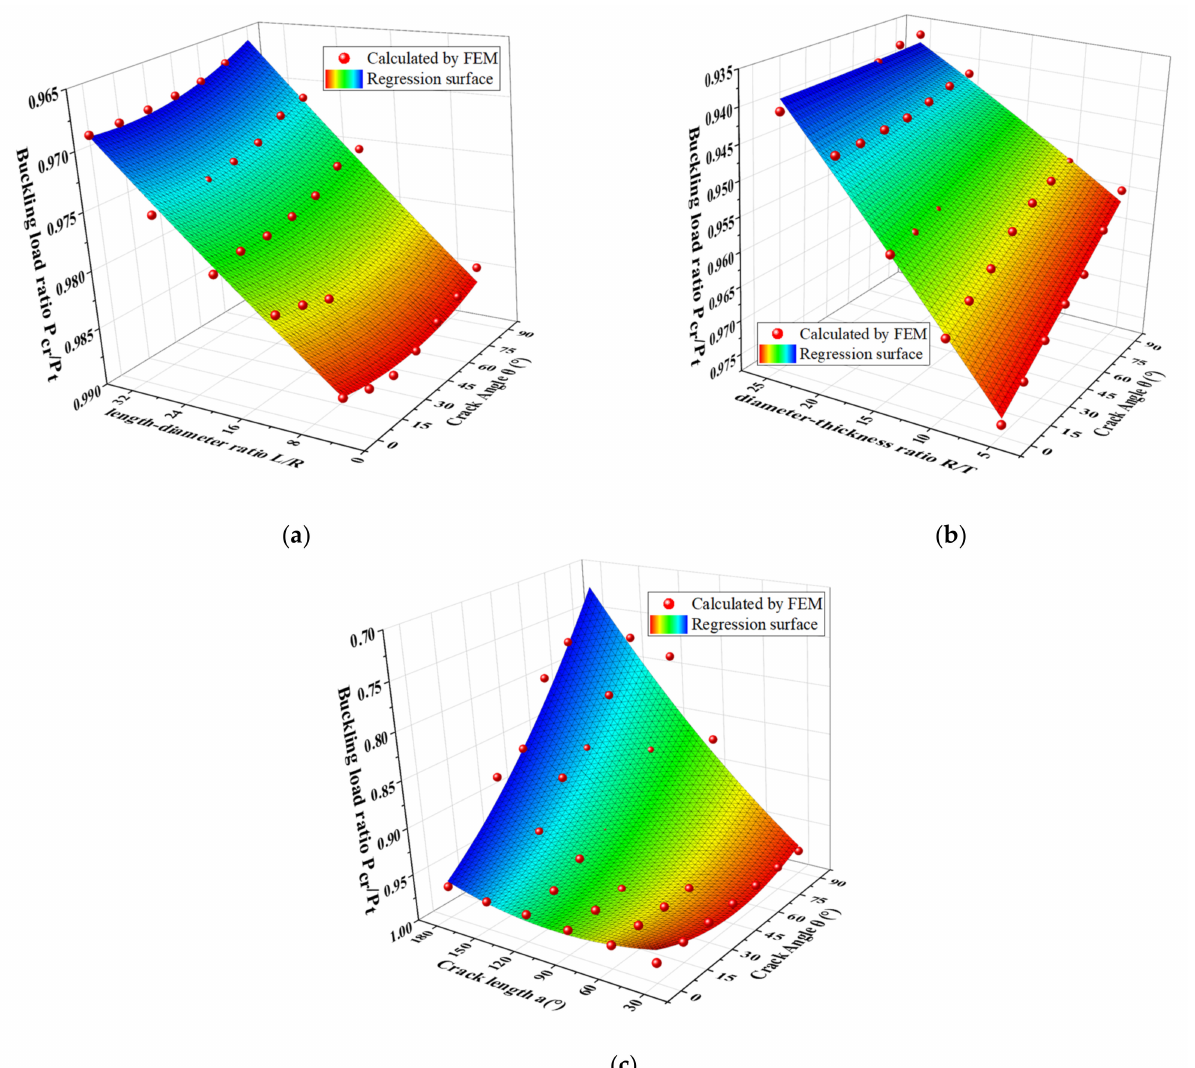
Figure 19. Relation of elastic-plastic buckling of cracked cylindrical shell with simple support ( a ) Different length-radius ratios and crack inclination angles; ( b ) Different radius-thickness ratios and crack inclination angles; ( c ) Different crack lengths and crack inclination angles.